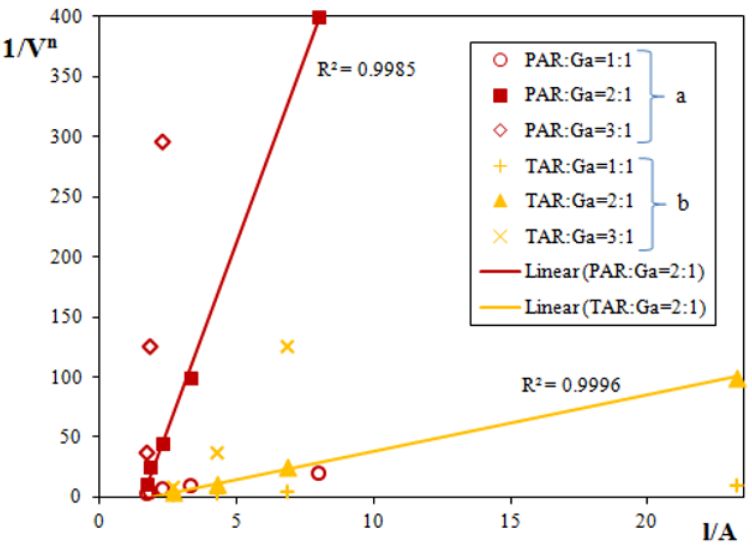
Figure 3. Determination of the ADR-to-Ga(III) molar ratios by the method of Asmus. a) Ga(III)-PAR-TTC system at pH=6.5, C